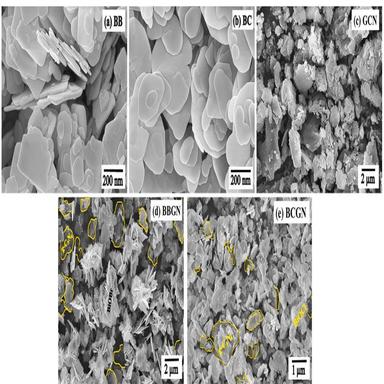
SEM images of (a) BB, (b) BC, (c) GCN, (d) BBGN and (e) BCGN nanomaterials.